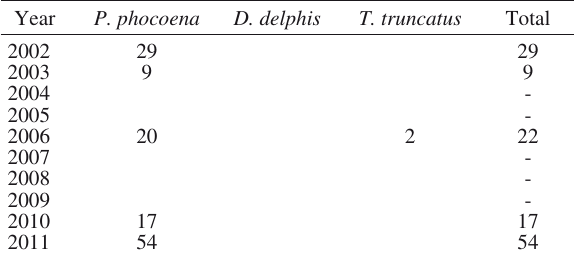
Table 1. – Dolphin accidental catches recorded on the Romanian littoral, during the past 10 years